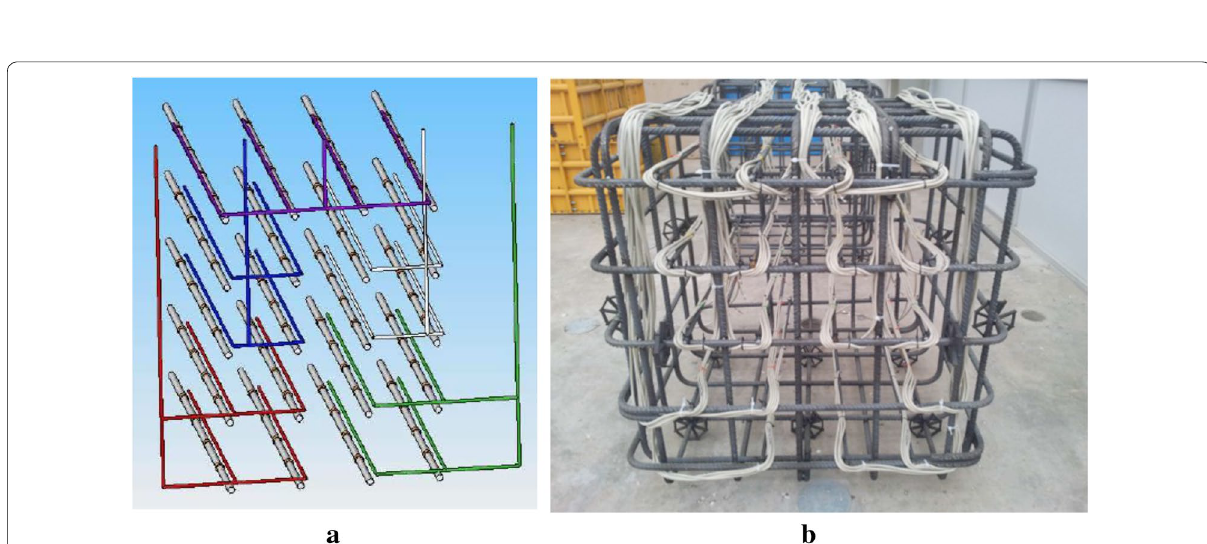
Fig. 2 Arrangement of the temperature sensors on the rebars: a assembly scheme, and b final